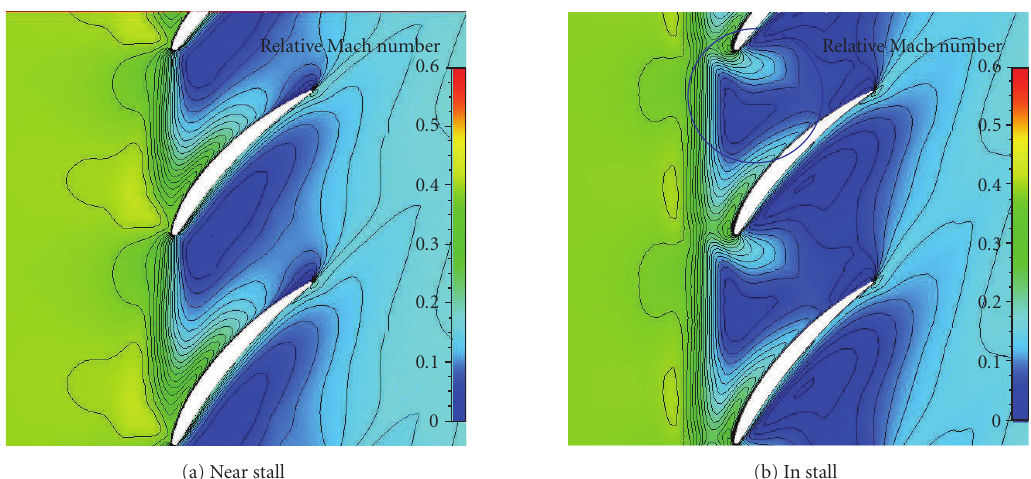
Figure 9: Comparison of Mach number distribution (99% blade span).